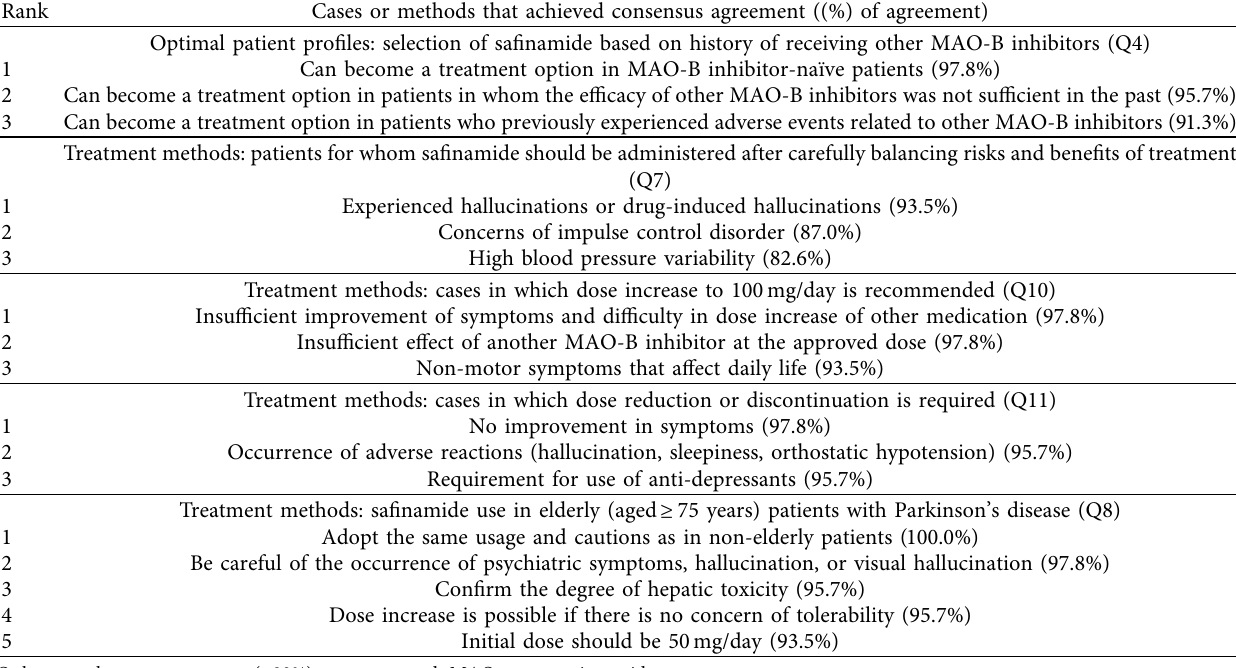
Table 1: Consensus of clinically important indicators or methods for the use of safinamide in each scenario. Rank Cases or methods that achieved consensus agreement ((%) of agreement)